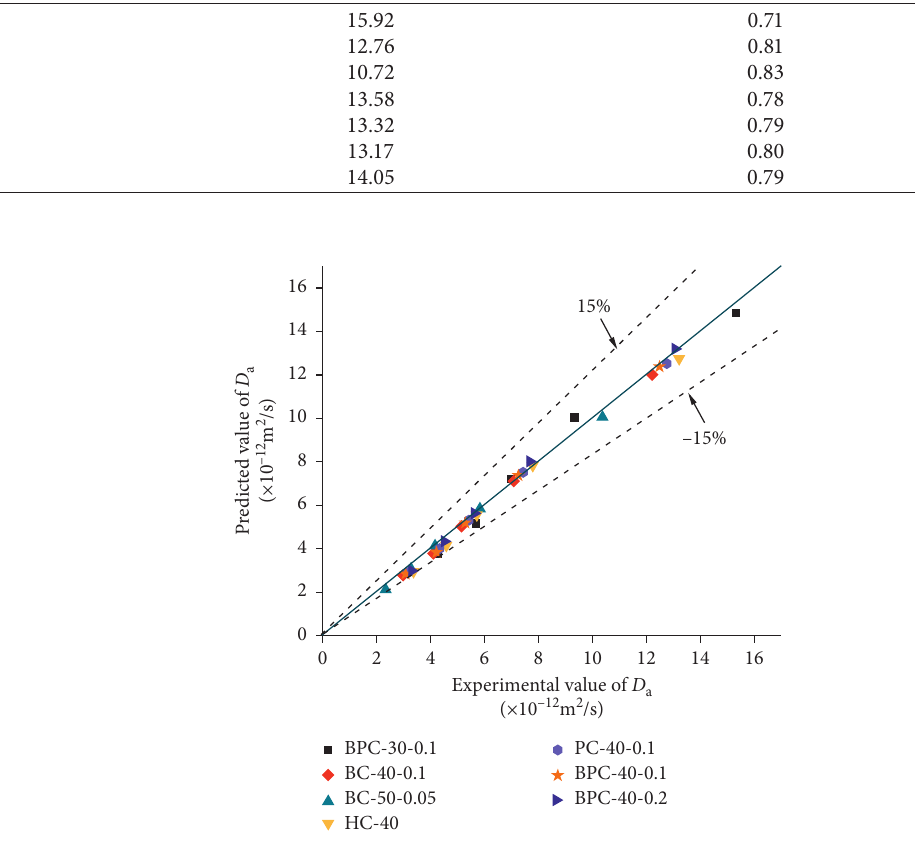
a for the BPFRC.